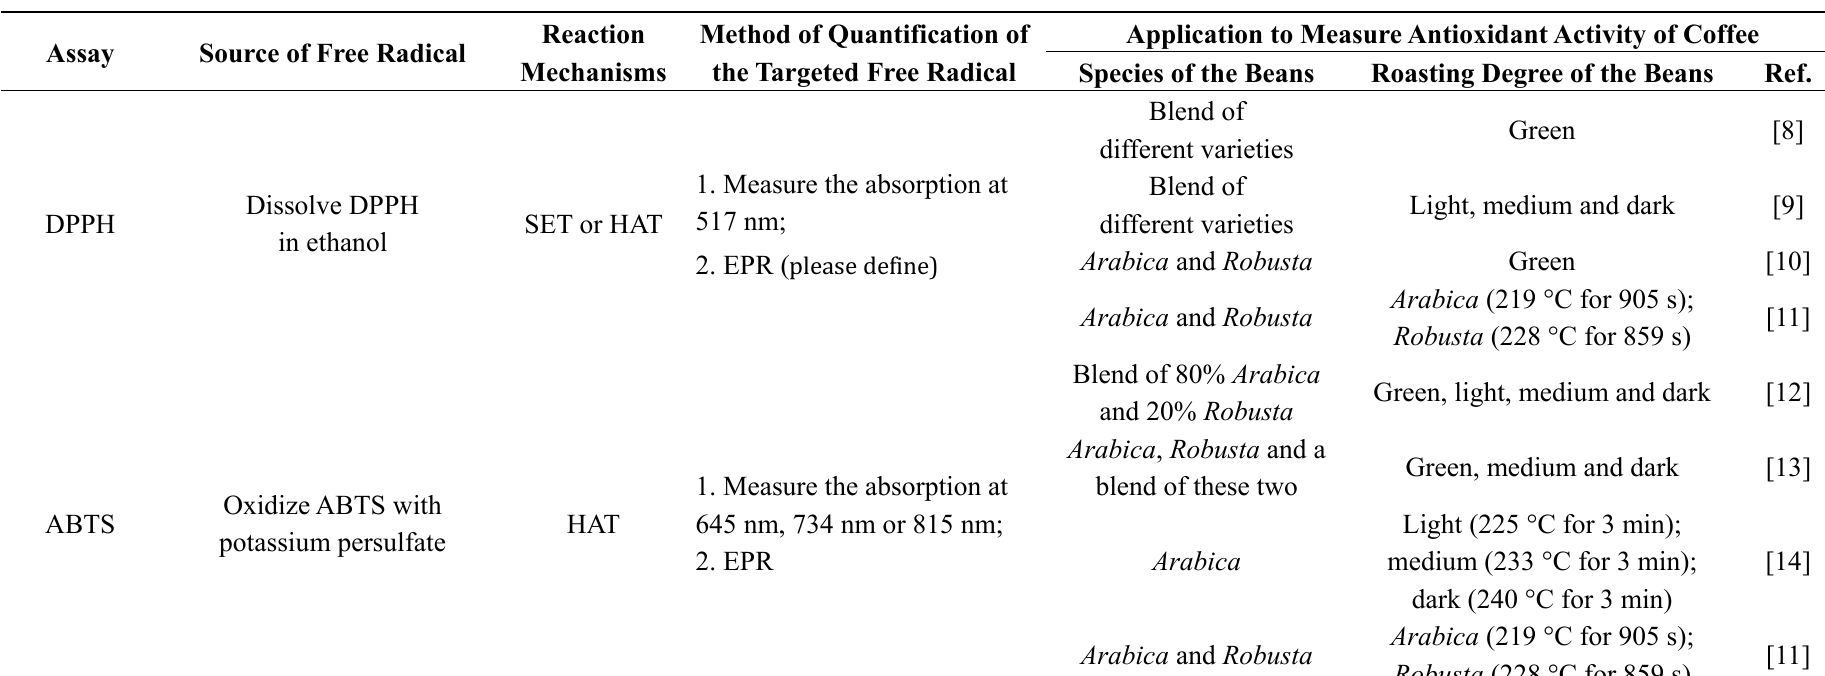
Table 1. Mechanisms of chemical assays commonly used to evaluate the antioxidant capacity of coffee and examples of the application of these assays to measure the antioxidant activity of coffee beans/drinks. SET, single electron transfer; HAT, hydrogen atom